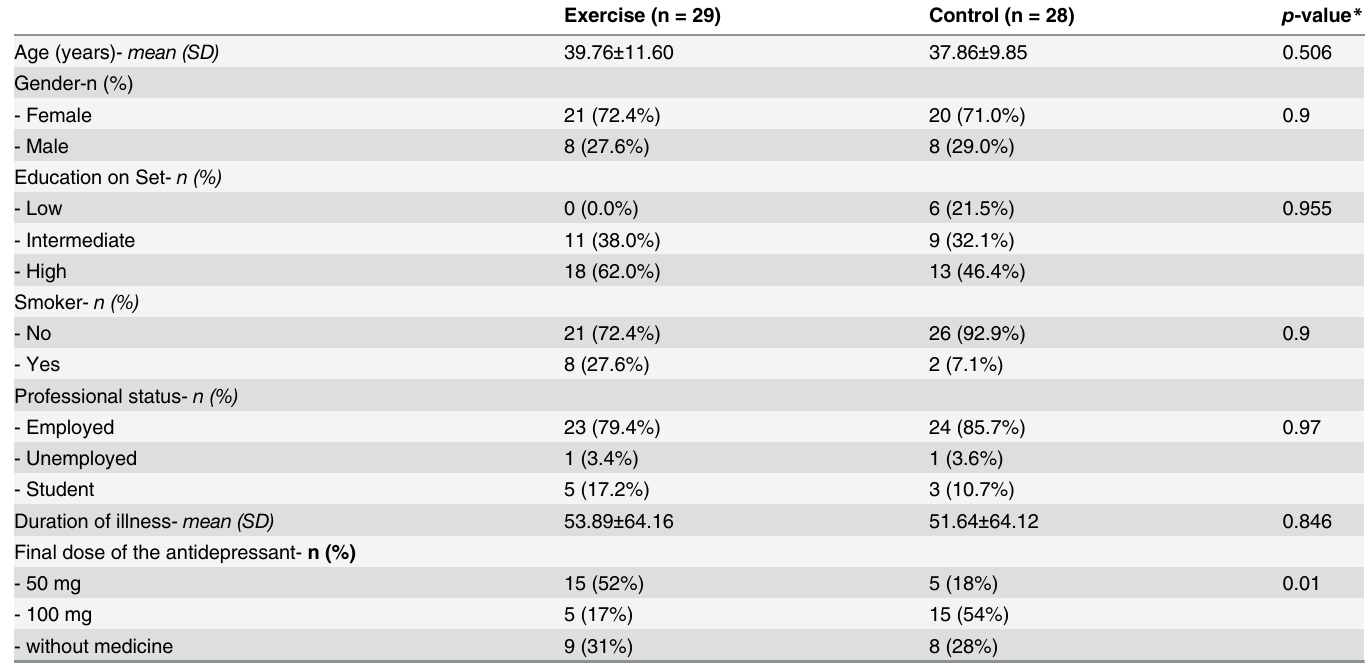
Table 1. Socio-demographic and medical characteristics in the exercise group and